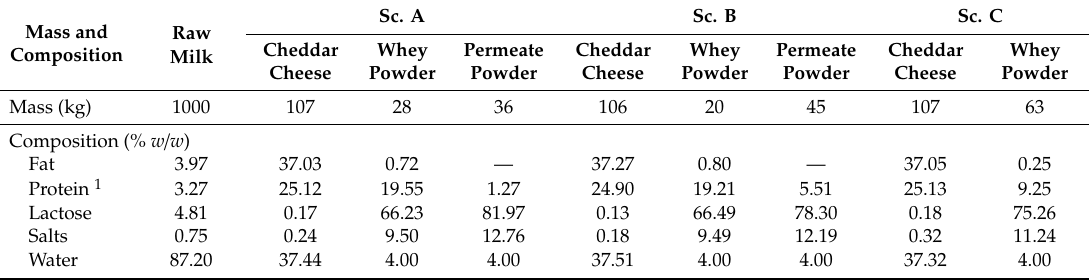
Table 2. Mass and composition of the raw milk, product, and coproducts generated in scenarios A, B, and C per ton of raw milk